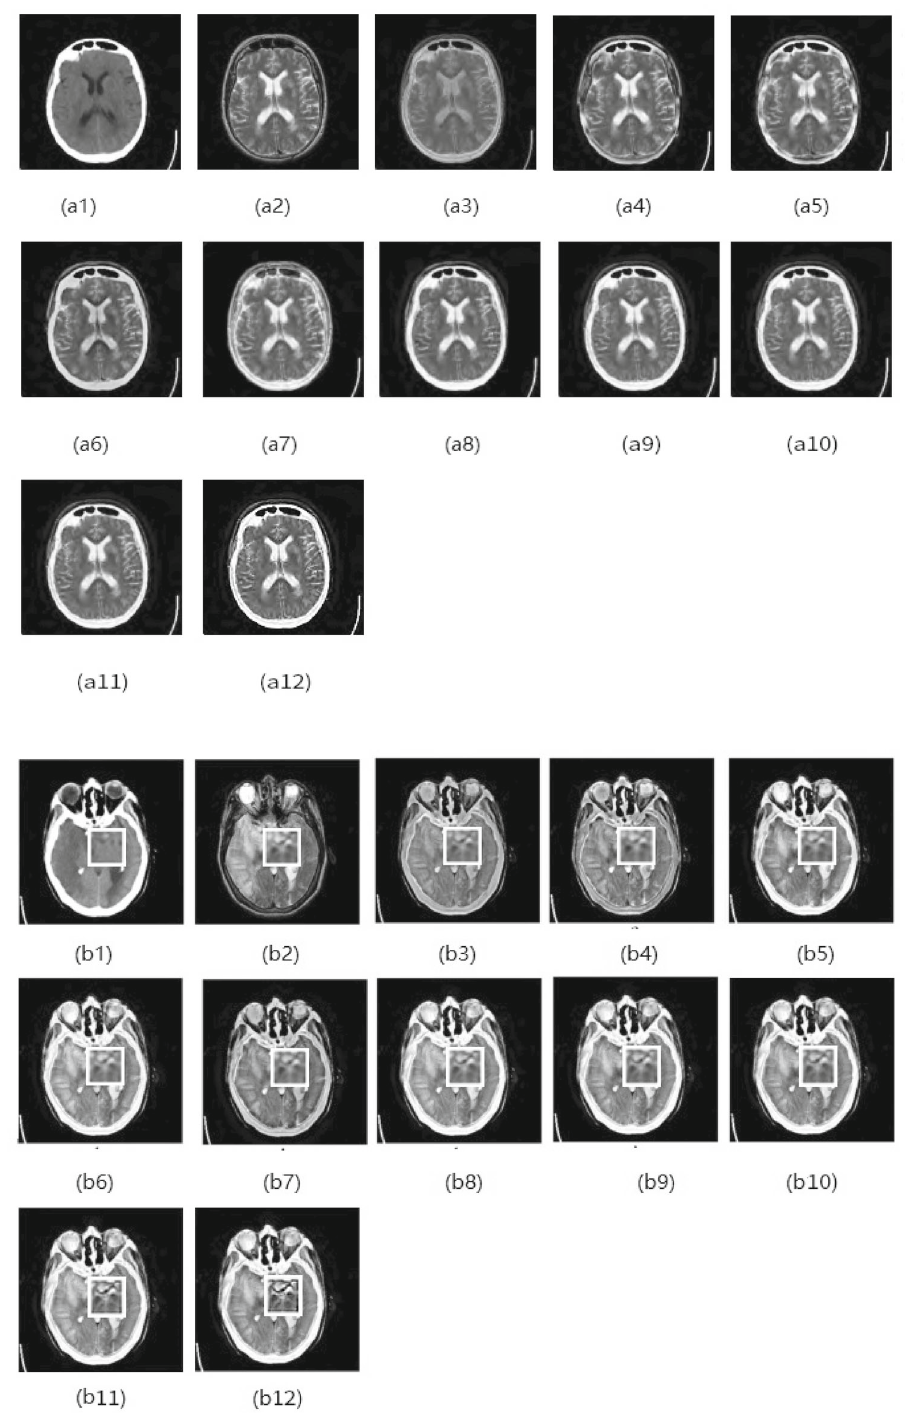
Fig. 4 Fusion results of two sets of CT–MRI images using different algorithms. a3 – a12 , b3 – b12 , respectively, denote the fused images of the LP–ASR, SR–NSCT, IOI–LLF,